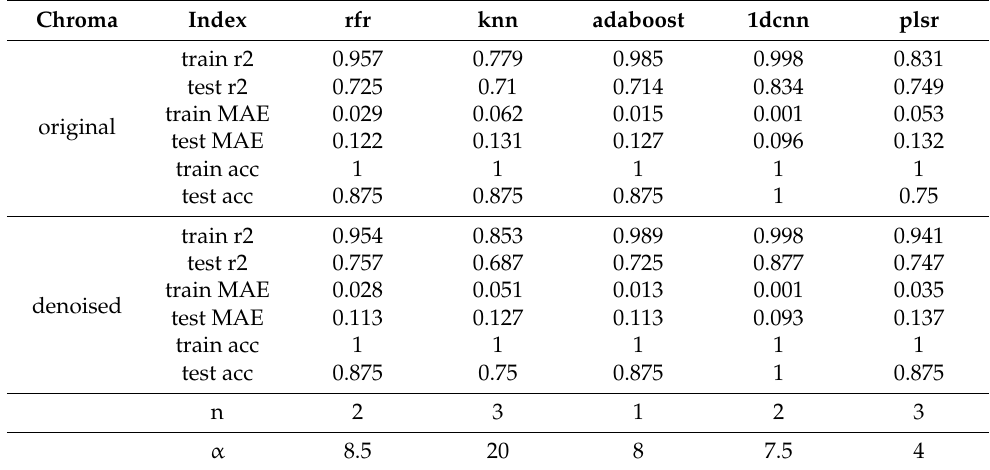
Table 5. The accuracy results of retrieving chroma.